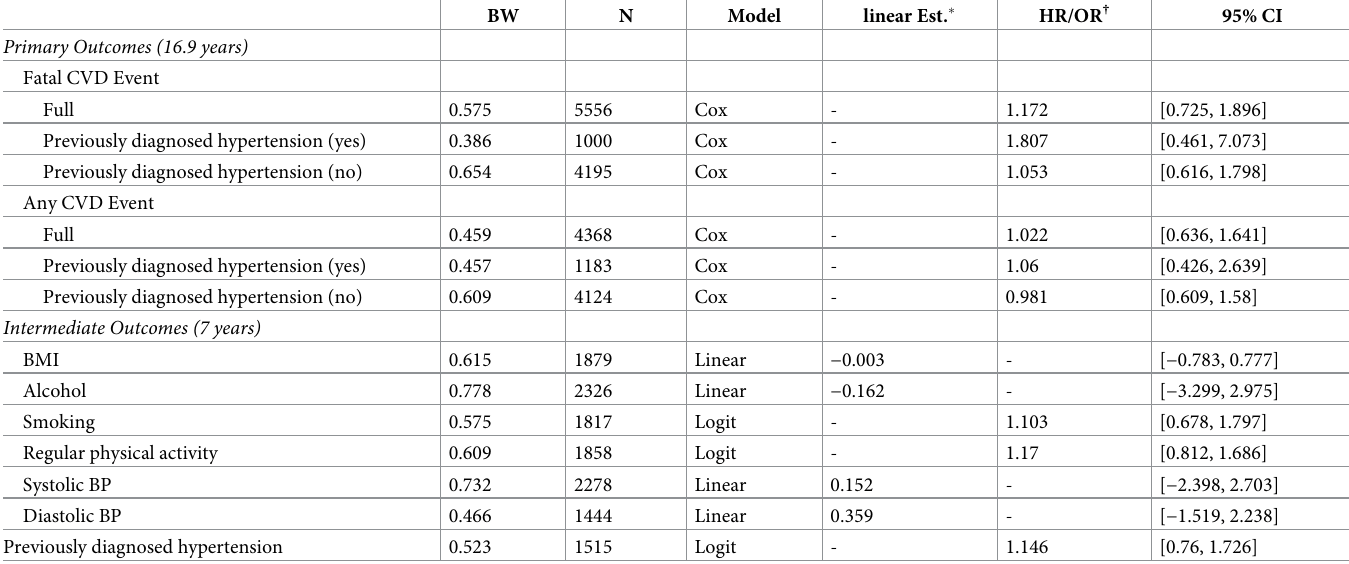
Table 2. Sharp RD analysis results.